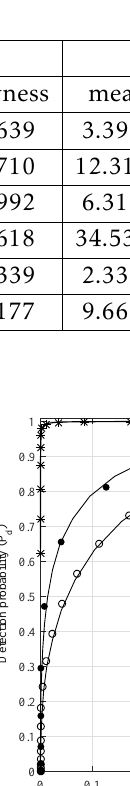
Table 1. Empirical mean, variance and skewness of the SCN under H approximation using Theorems 1 and 2 respectively.